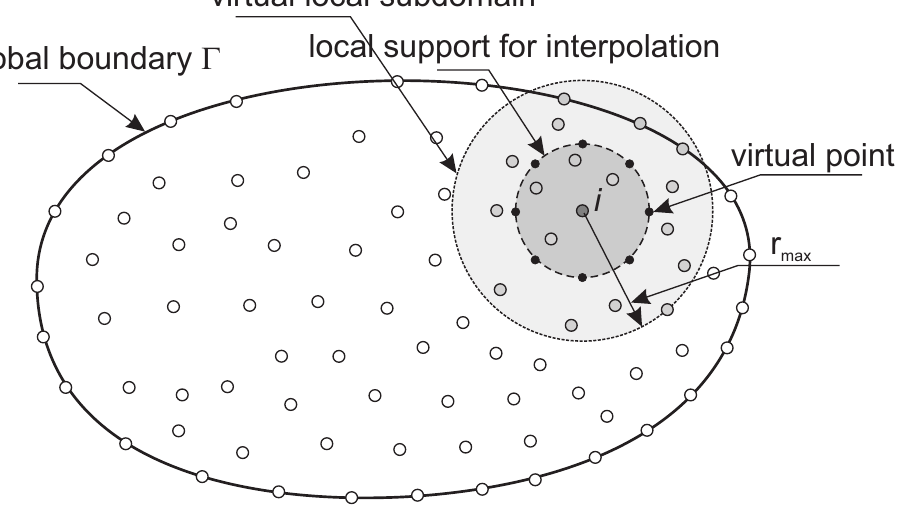
Figure 1. Virtual and supporting nodes in the domain Ω